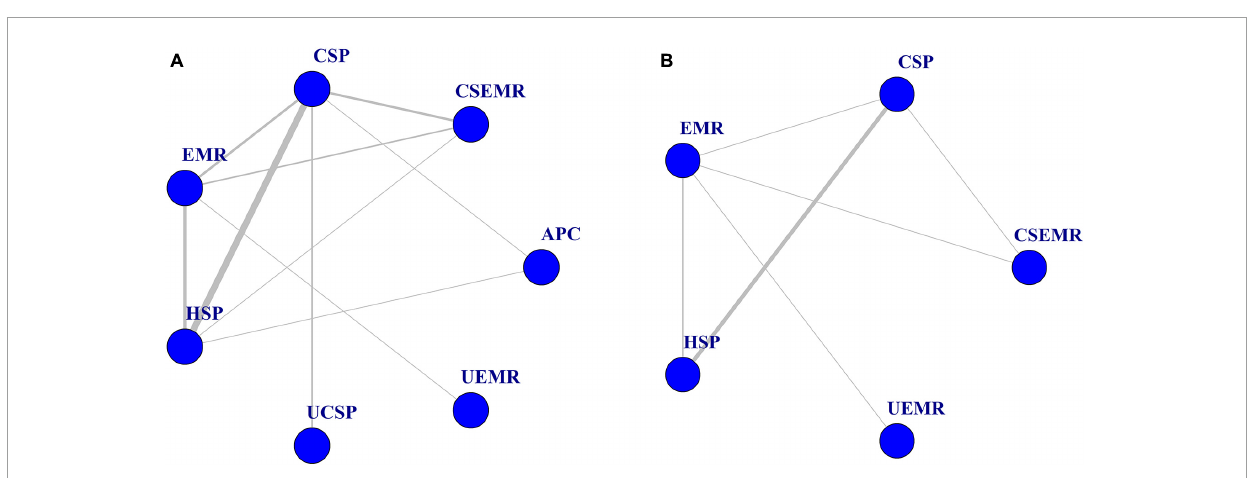
FIGURE2 Evidence network of eligible comparisons for network meta-analysis. (A) Complete resection rate ( n = 17). (B) Intraprocedural bleeding rate ( n = 11). Lines connect the interventions that have been compared directly (head-to-head) in the eligible randomized controlled trials (RCTs).